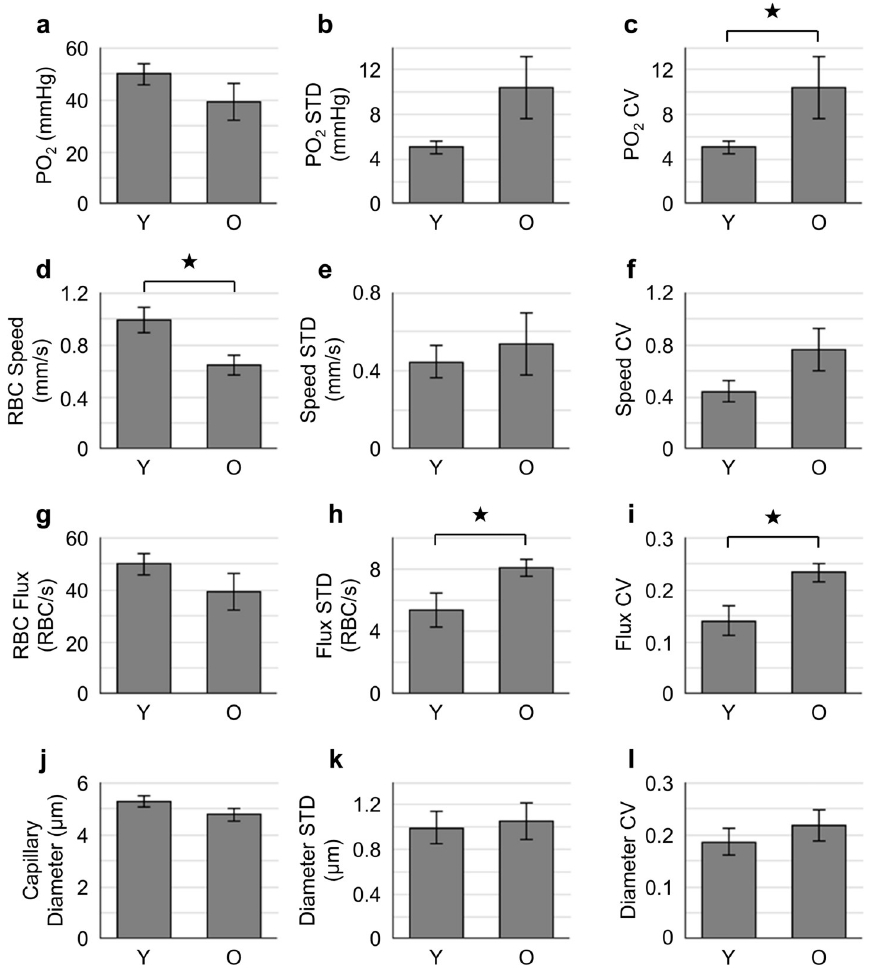
Fig 4. Comparisons of cortical tissue PO 2 , capillary RBC flow and diameter between the young (Y) and old (O) atherosclerotic mice. a-c. Absolute tissue PO 2 , PO 2 STD and CV; d-f. absolute RBC speed, speed STD and CV; g-i. absolute RBC flux, flux STD and CV; j-l. absolute capillary diameter, diameter STD and CV. The data presented in a-c was based on 100–200 samples acquired per mouse. The analysis in d - l was made with the measurements acquired in 15 capillaries per mouse. In a-l , for each age group, data were first averaged with all the measurements in each mouse, and then over mice. Data are expressed as mean ± SEM. The star symbol indicates significant difference (P < 0.05, Student’s